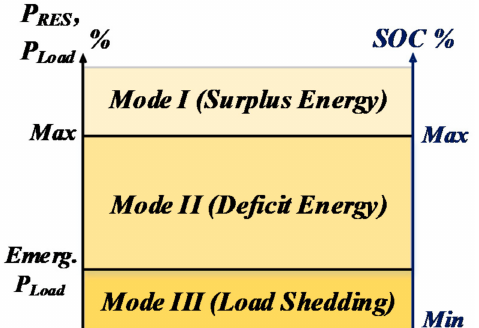
Figure 2. Microgrid various operating